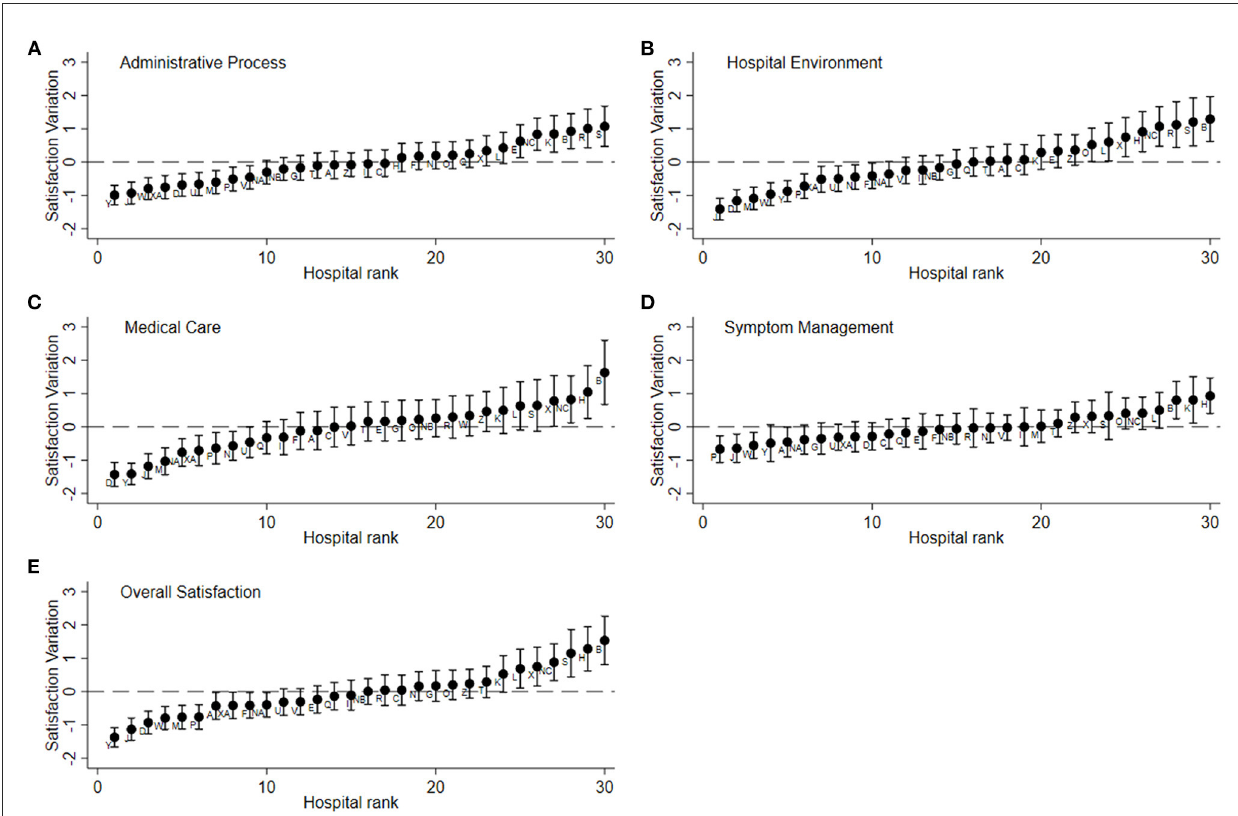
FIGURE2 Satisfaction variation among hospitals after case-mix adjustment. (A) Administrative process, (B) hospital environment, (C) medical care, (D) symptom management, (E) overall satisfaction. Y axis, satisfaction variation (random effect and standard error) by hospitals; X axis, hospital rank sorted by random effect. All models are adjusted with variables: sex, age, education, annual family income, cancer type, cancer stage, self-reported health status, length of stay and actual